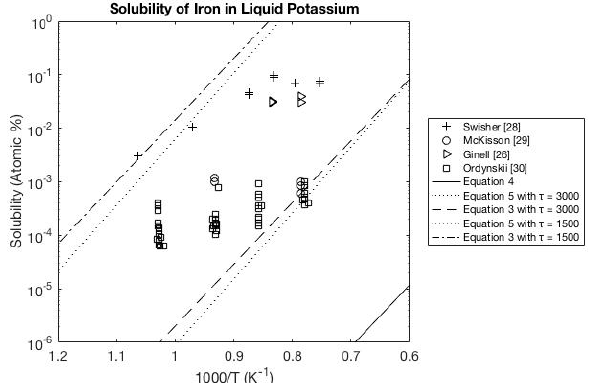
Figure 8. Solubility of iron in liquid potassium.